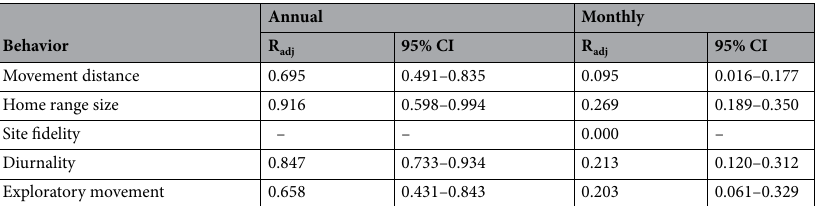
Table 1. Individual repeatability from the best supported univariate models of each movement behavior at each spatial scale (annual and monthly). Where: individual repeatability ( R adj ) is the proportion of variance attributable to among-individual differences after controlling for the fixed effects; 95% CI is the 95% credible interval calculated from the posterior distribution around the individual repeatability estimate. For conditional and marginal R 2 from each univariate model see Supplementary Table 3.